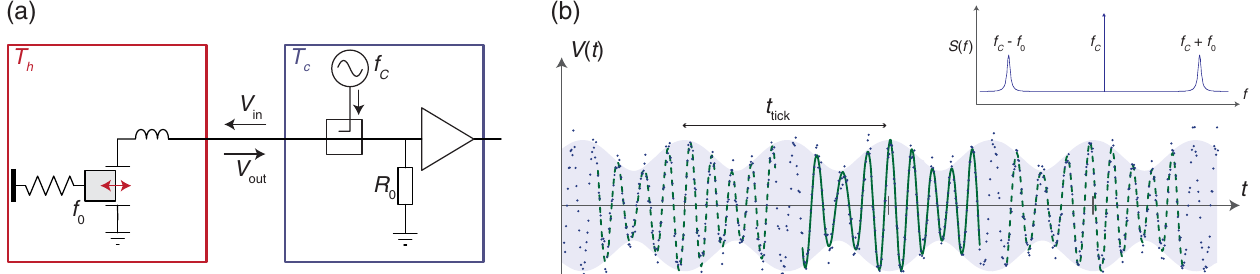
FIG. 6. The thermomechanical clock. (a) The setup. An optomechanical circuit consists of an LC tank circuit whose capacitance, and therefore frequency, is modulated by a thermomechanical resonator at temperature T . To use the vibrations in a clock, the tank circuit is h illuminated by a carrier tone V at frequency f , giving rise to a reflected signal V which is passed to a cold matched resistor and c in out amplifier. The effect of the vibrations is to modulate the phase of V . (b) Sketch of the resulting voltage record at the amplifier input out (points), with fits (lines) from which each tick is extracted. The modulation envelope is indicated by the shaded background. Inset: power spectrum at the amplifier input, showing uniform noise background, central delta-function peak from the carrier, and two thermomechanical sidebands. In the experiment, a demodulation circuit was applied after the amplifier [as in Fig. 2(d)] because it makes ticks practically easier to identify in the record. However, the demodulator cannot improve the clock accuracy because it cannot increase the timing information present in the signal V ð t Þ ; in fact, a detailed calculation would show that the accuracy is unchanged. For simplicity, the demodulator is therefore omitted from this